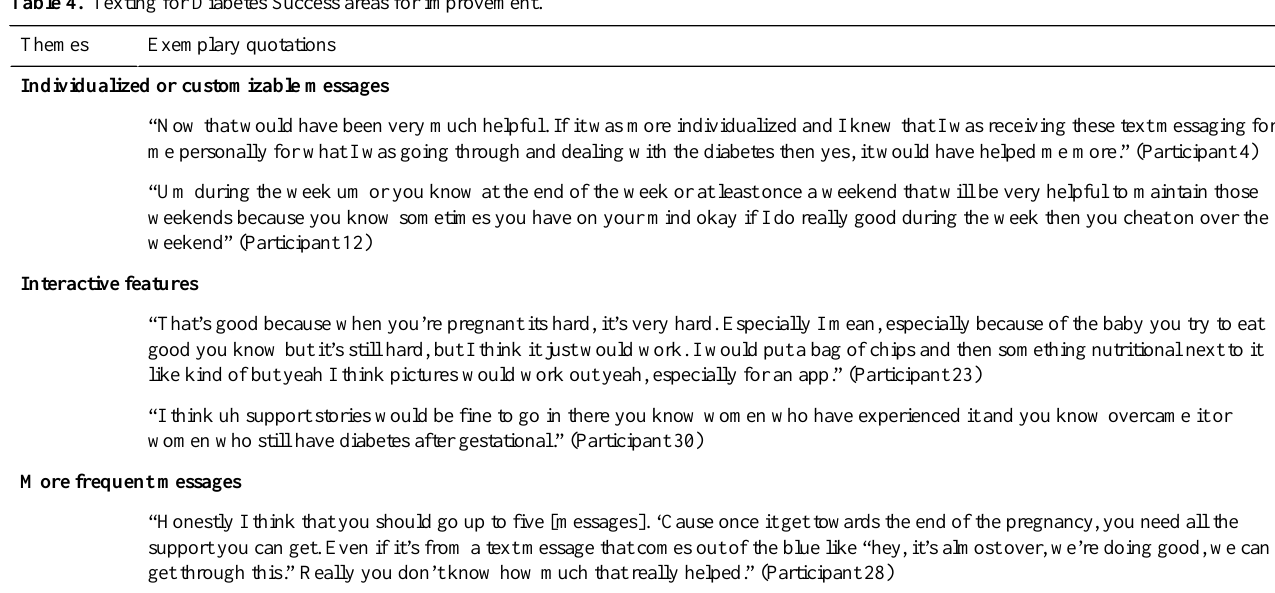
Table 4. Texting for Diabetes Success areas for